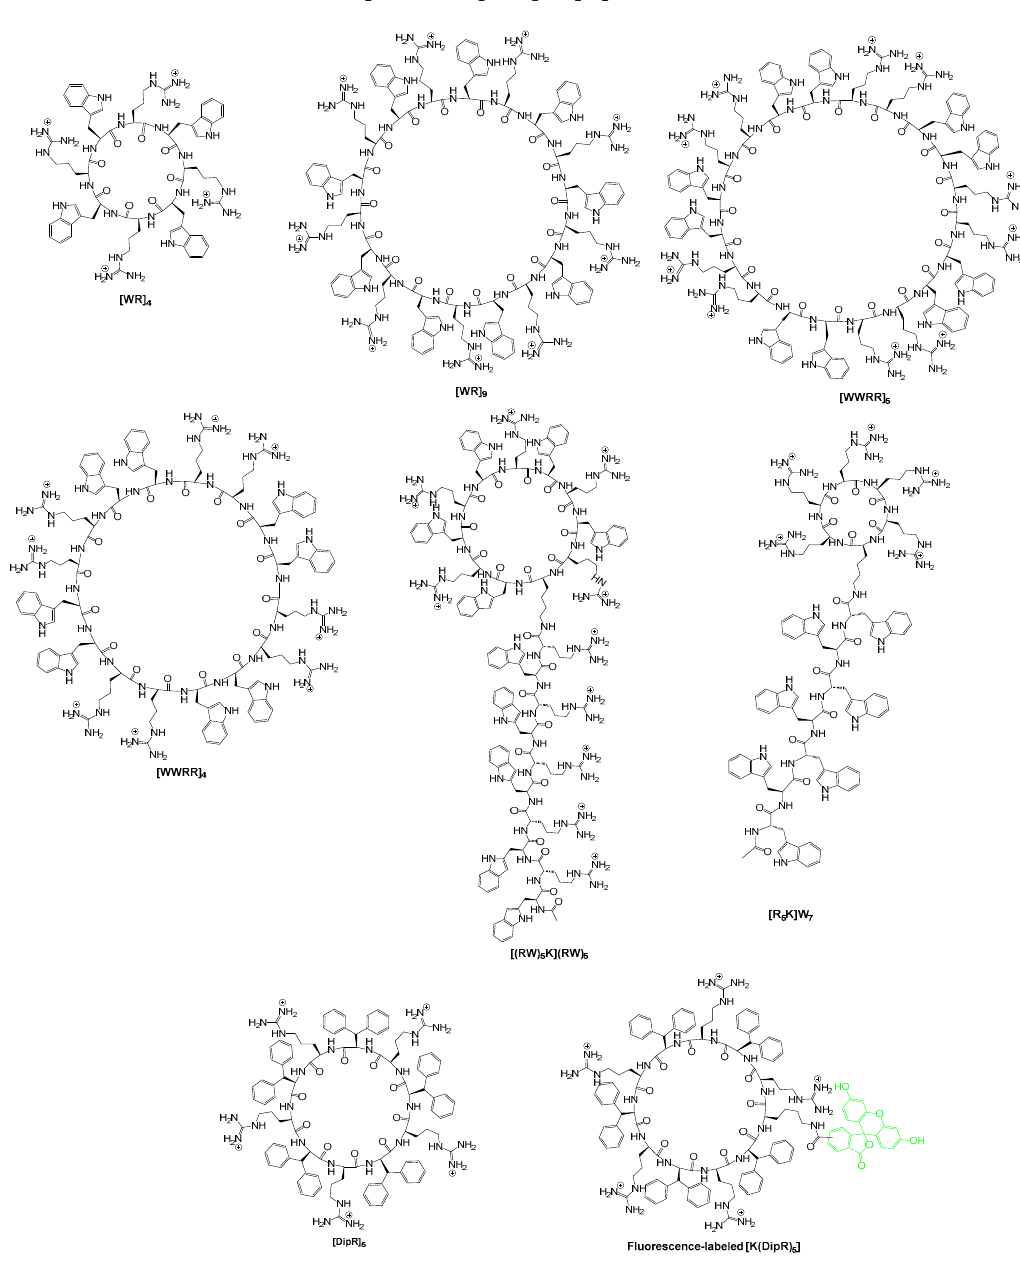
Figure 1. Chemical structures of peptides containing arginine and hydrophobic residues.